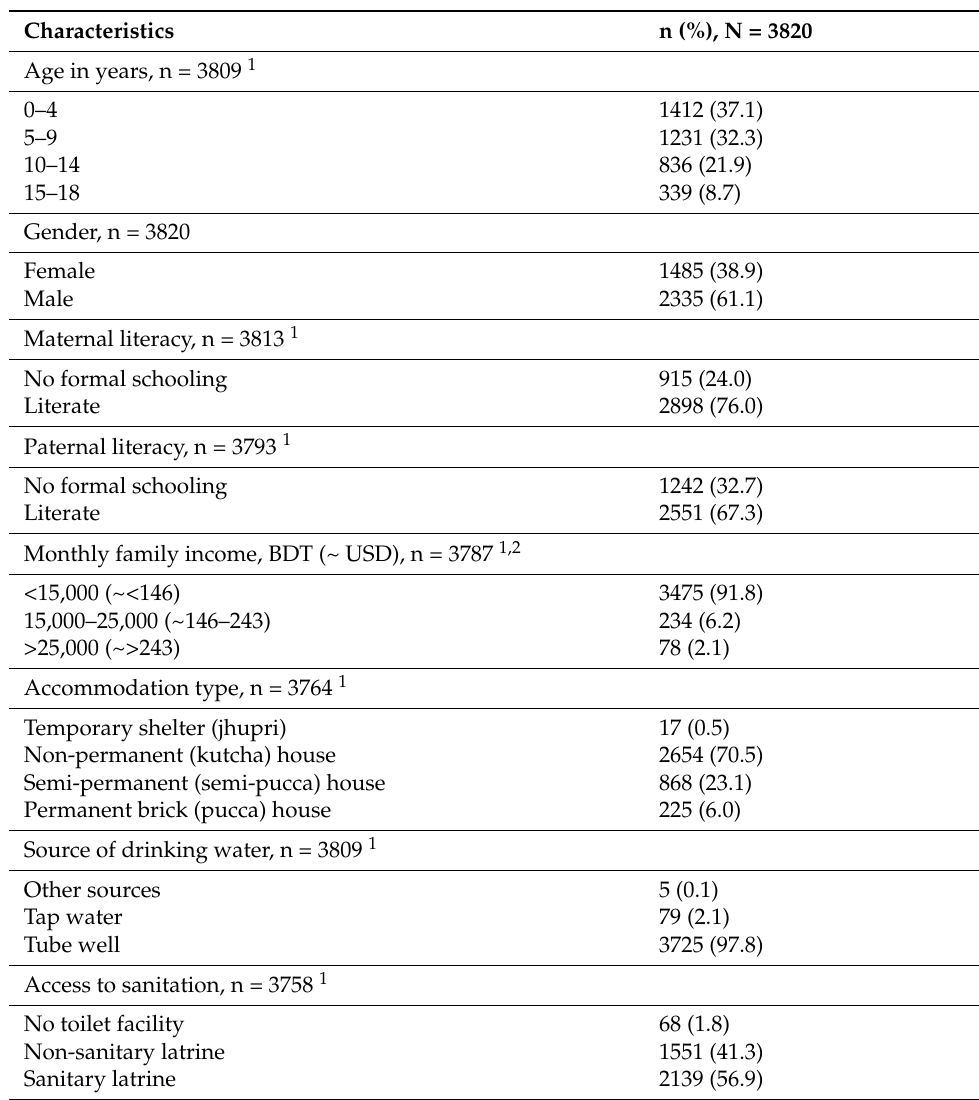
Table 1. Cohort profile (socio-demographic characteristics, predominant motor type, topography, and GMFCS